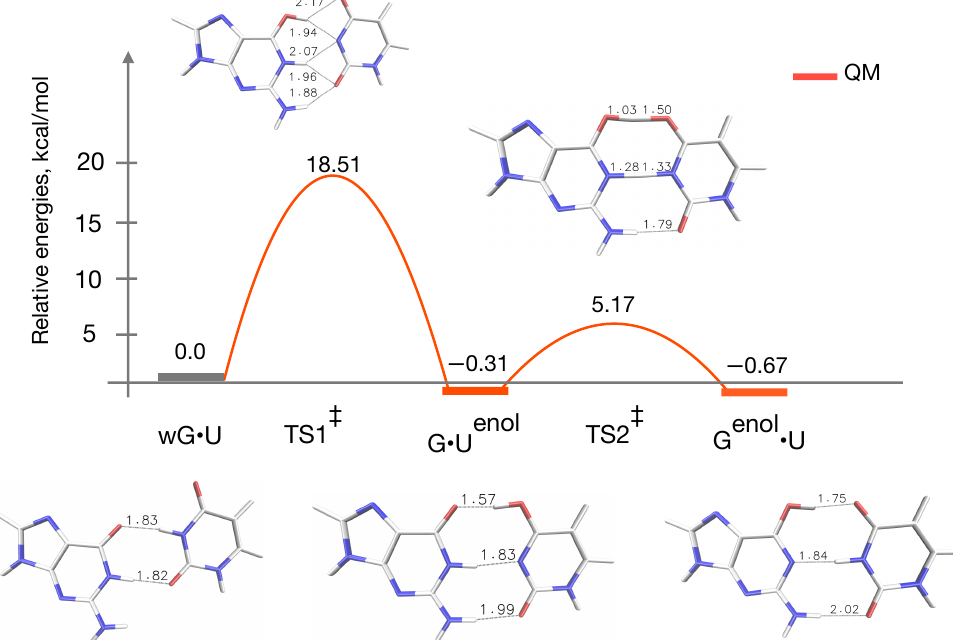
Figure 3. Reaction energy profile and geometries of reaction intermediates and transition states